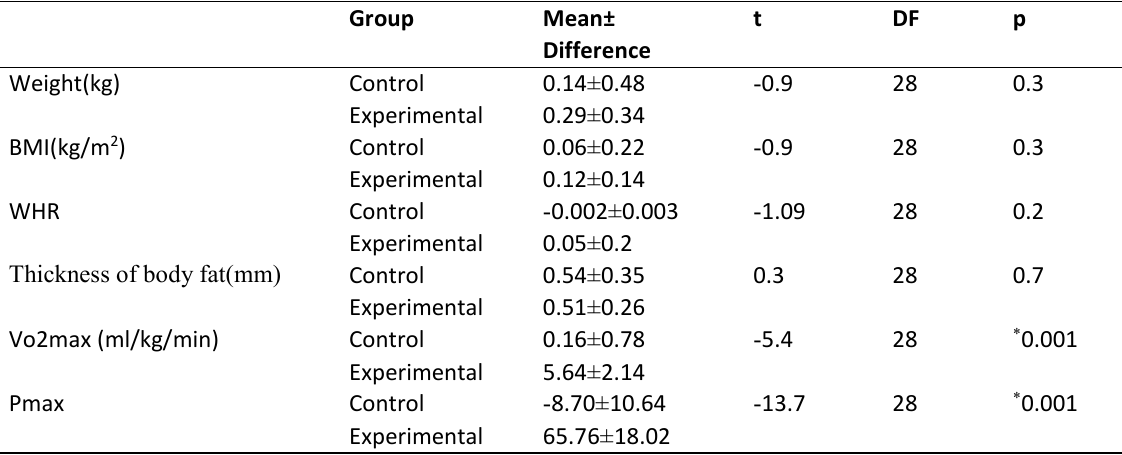
Table 4. In depended t-test between groups